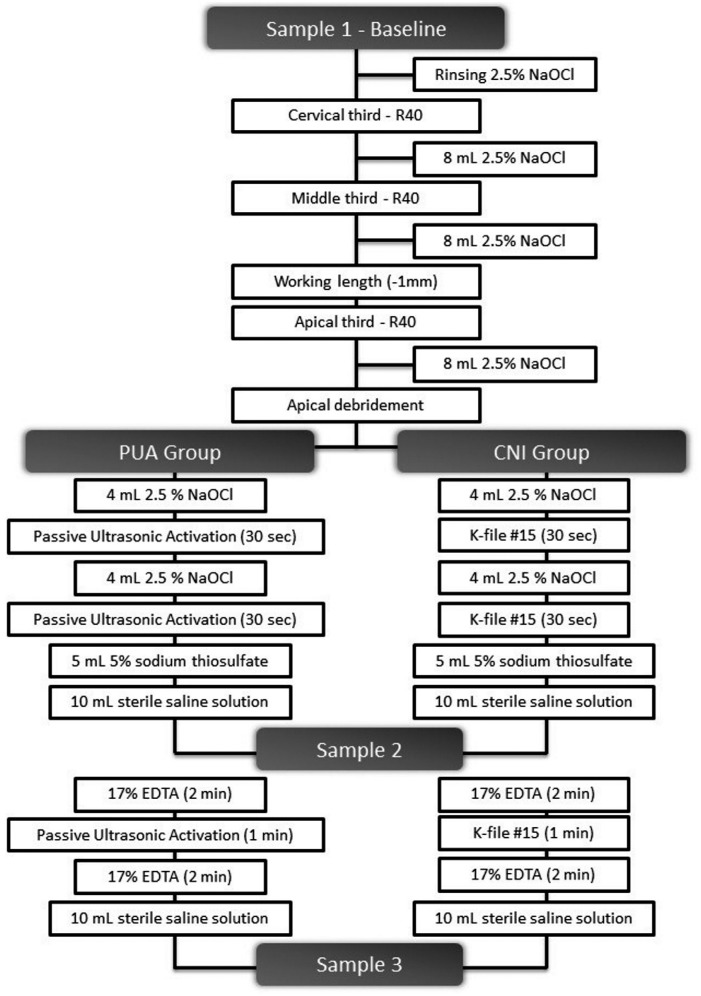
Flow diagram of interventions and sampling procedures